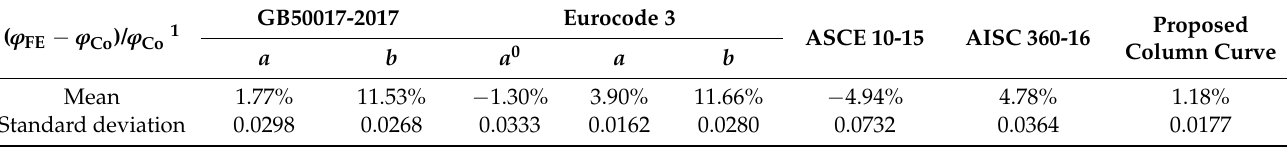
Table 6. Comparison between Q345 LAS FE results and design